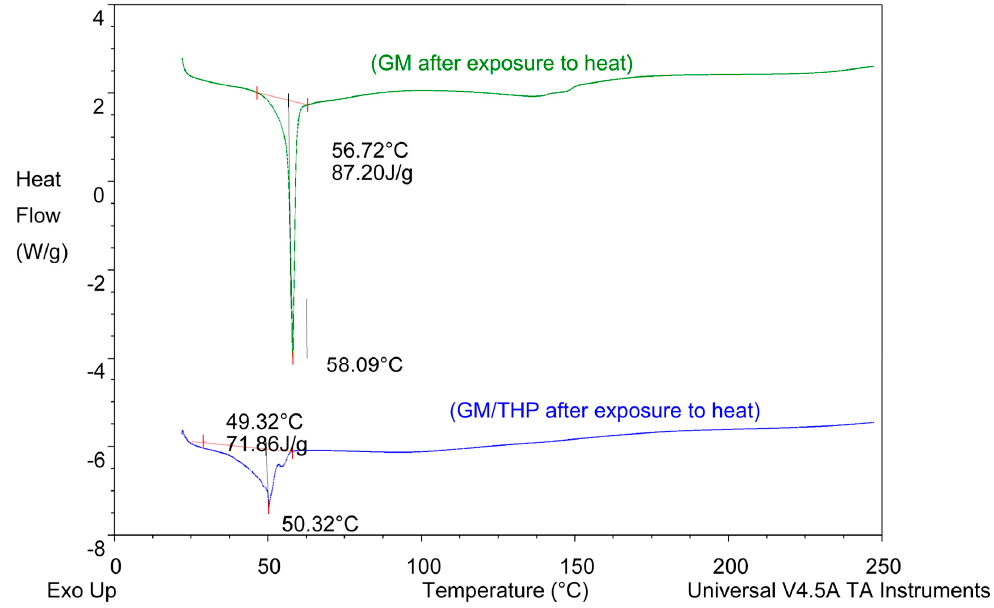
Figure 8. DSC thermograms of EFV prior to and following exposure to a temperature of 70 ◦ C for 1 h.